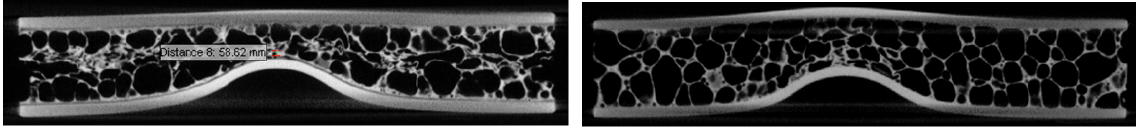
Figure 15: Tomographic images of the damaged AFS panels (left Alulight ; right Schunk ) after the impact (v = 2 m/s).